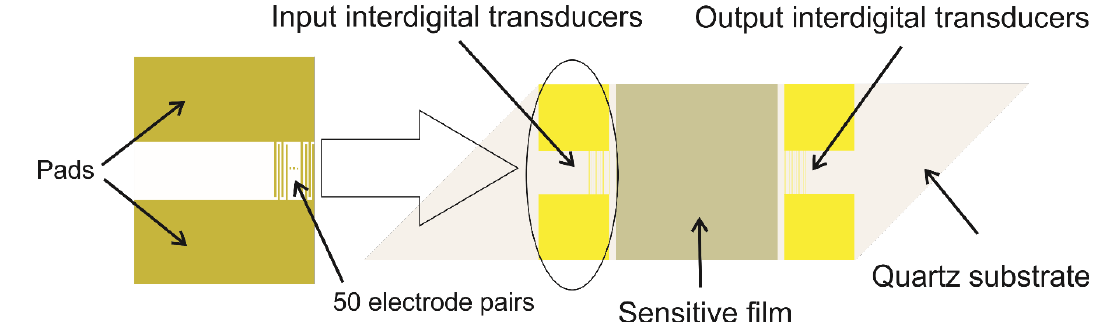
Figure 1. Scheme of a surface acoustic wave (SAW) delay line [44].